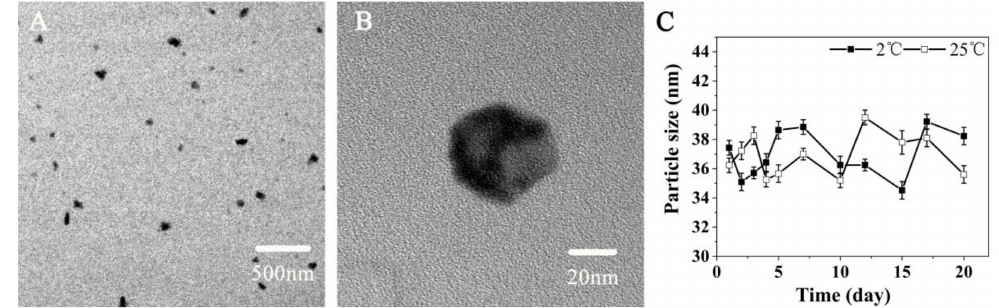
Figure 6. TEM images of CuS nanoparticles and particle size stability of CuS nanoparticles in difference time. ( A,B ) TEM images of CuS nanoparticles, ( C ) The particle size stability of CuS nanoparticles in difference